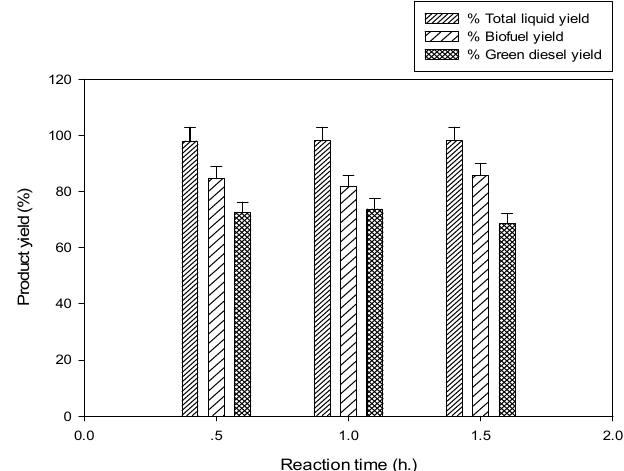
Figure 7. Effect of reaction time on hydrotreating of RBO.